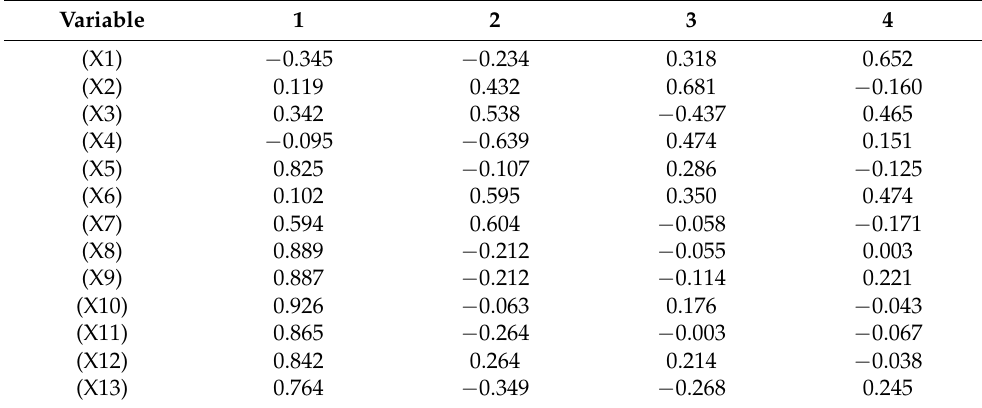
Table 4. Square comprehensive evaluation principal component factor load matrix.